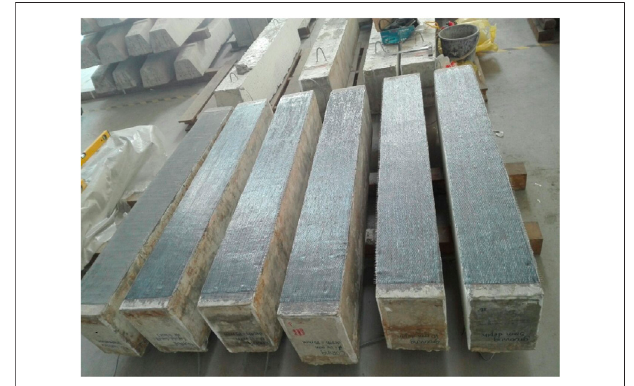
FIGURE 4 | The installed CFRP on the beam surface.